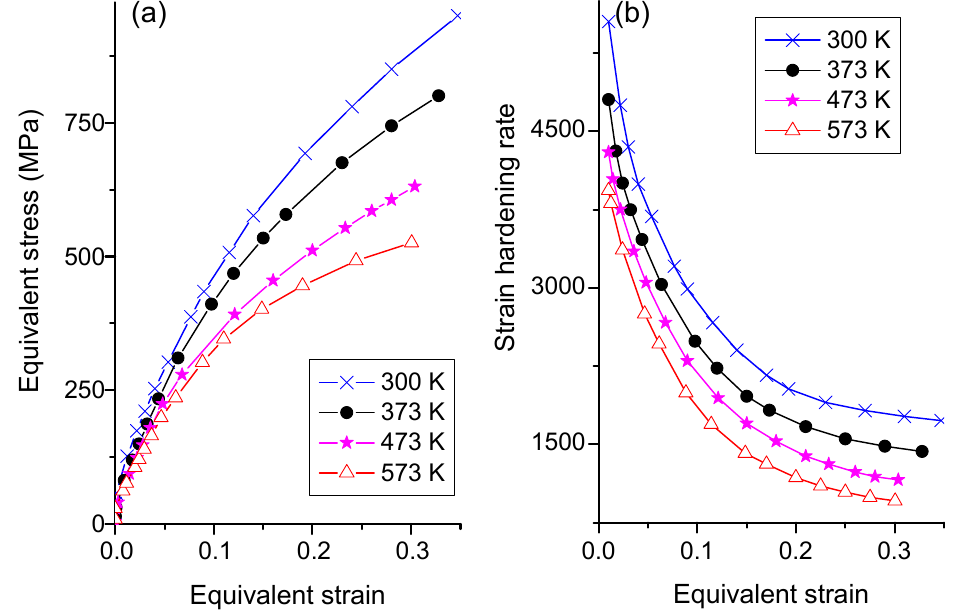
Figure 12. The equivalent strain versus equivalent stress curves ( a ) and the strain hardening rate curves ( b ) at different temperatures.